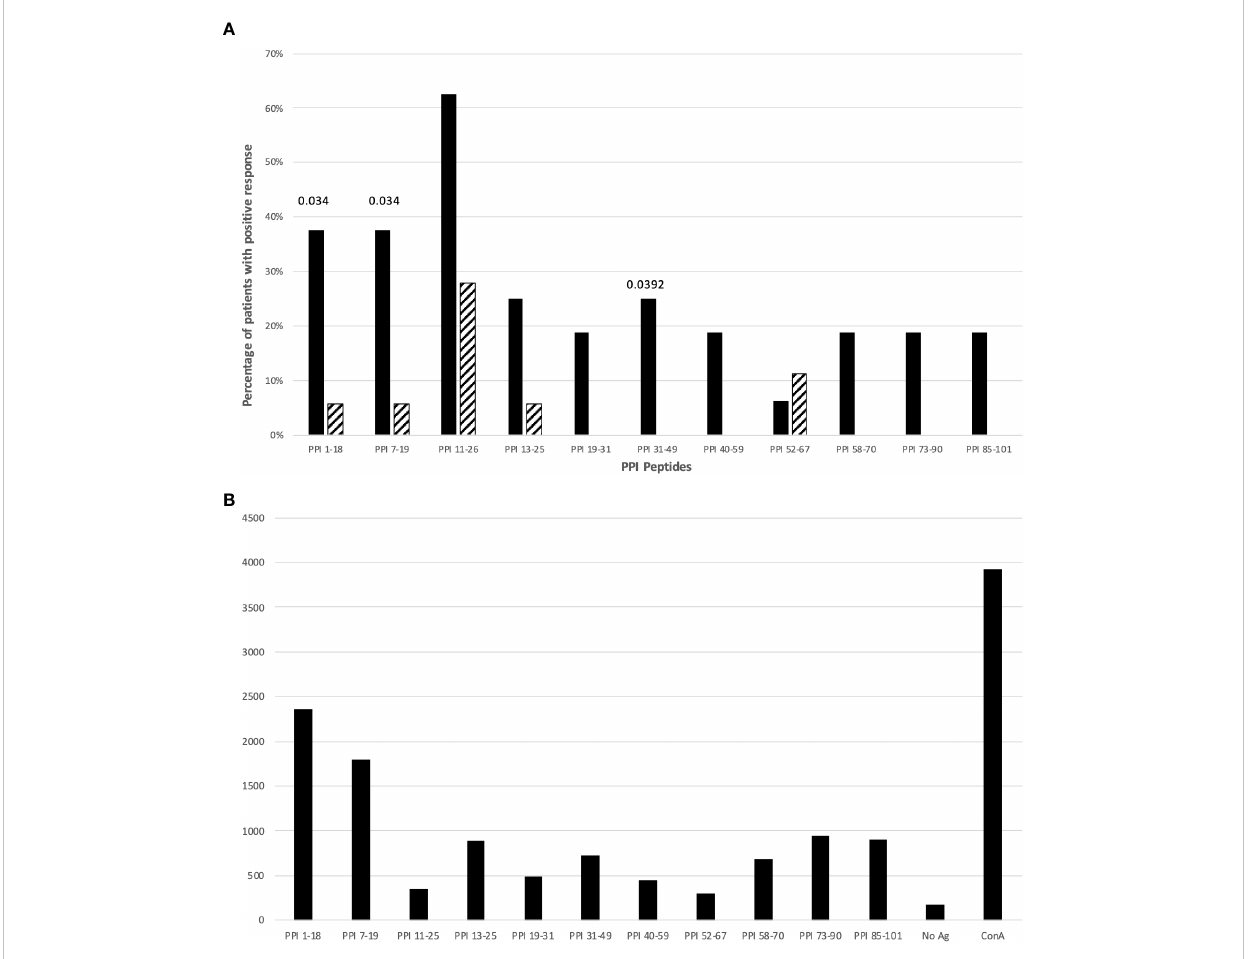
FIGURE 1 (A) Percentage of T1D patients (solid bars) and controls (hatched bars) responding to PPI peptides. Signi fi cant p values (<0.05) are indicated above the corresponding bars. Statistical analysis was performed using the Fisher ’ s exact test. (B) The fi gure shows cpm response with different PPI peptides in a T1D patient (n. 11, Table